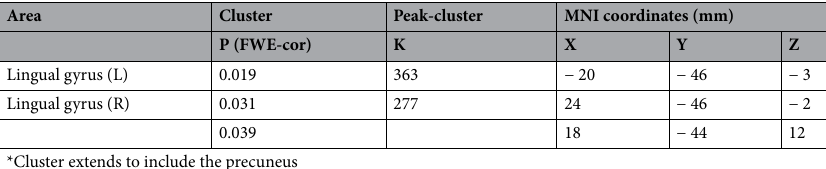
Table 3. The coordinates for the local maxima of gray matter volume differences between the hearing loss groups with and without tinnitus. These areas shows more gray matter volume in the hearing loss group with tinnitus, compared to the hearing loss group without tinnitus. The comparison between the tinnitus group and the controls did not reveal a significant group difference, and is therefore not shown in this table.